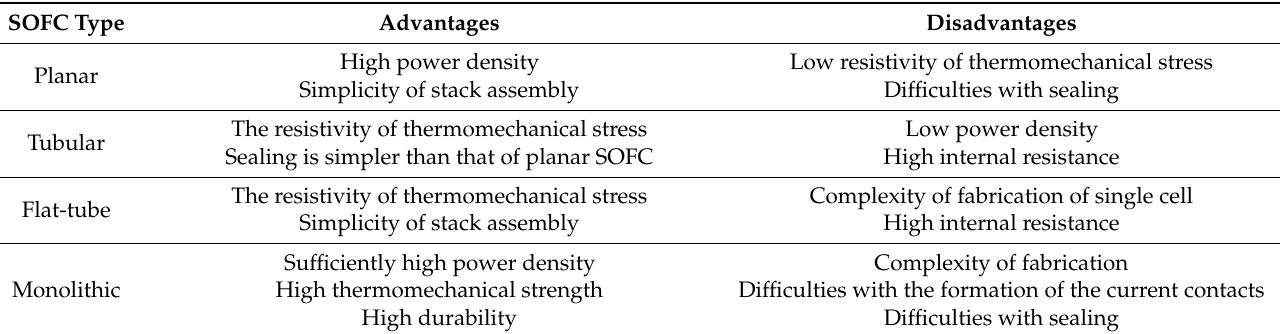
Figure 6. Schematics of ( a ) monolithic stack and ( b ) cathode-supported honeycomb SOFC. Table 4 summarizes the advantages and disadvantages of the four main SOFC designs. Table 4. Features of the different SOFC